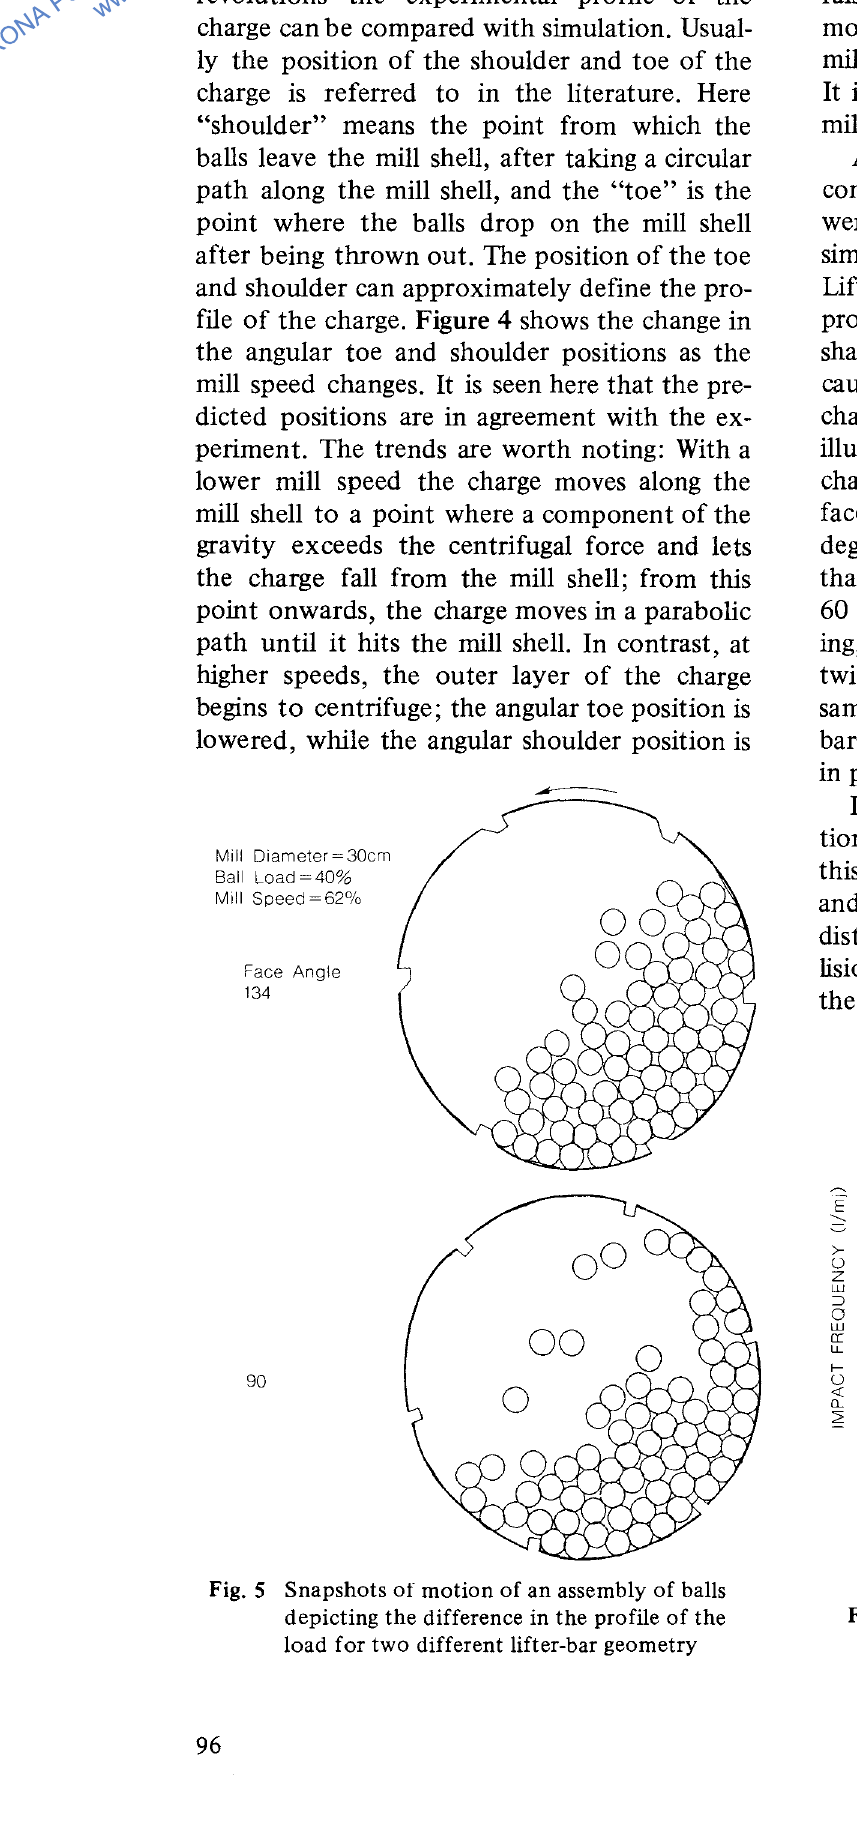
Fig. 6 Frequency distribution of energy between collisions for different mill